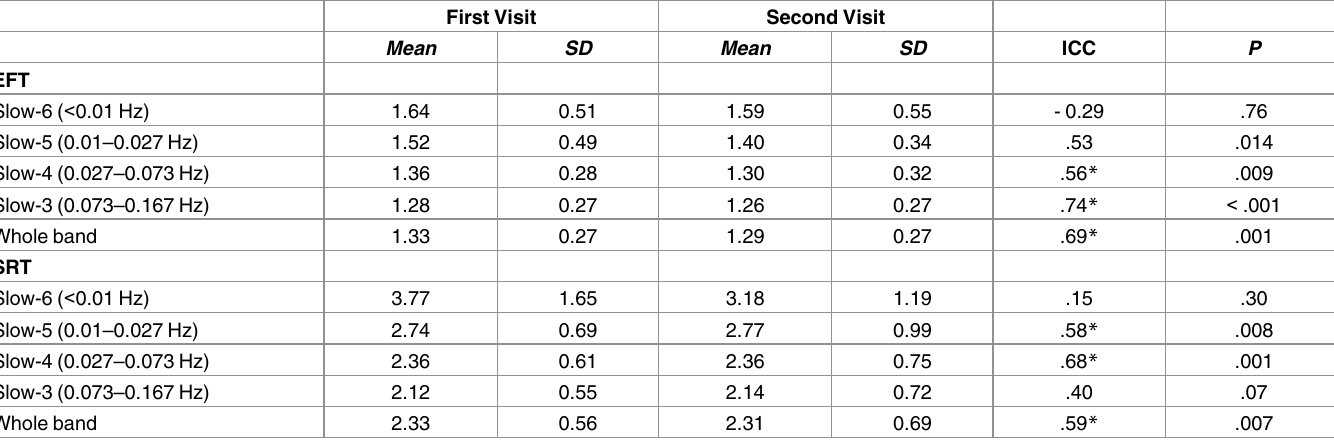
Table 3. Intra-class correlation (ICC) coefficients of RT-ALFF between iterations of the Eriksen flanker task (EFT) and simple reaction task (SRT). First Visit Second Visit Mean SD Mean SD ICC